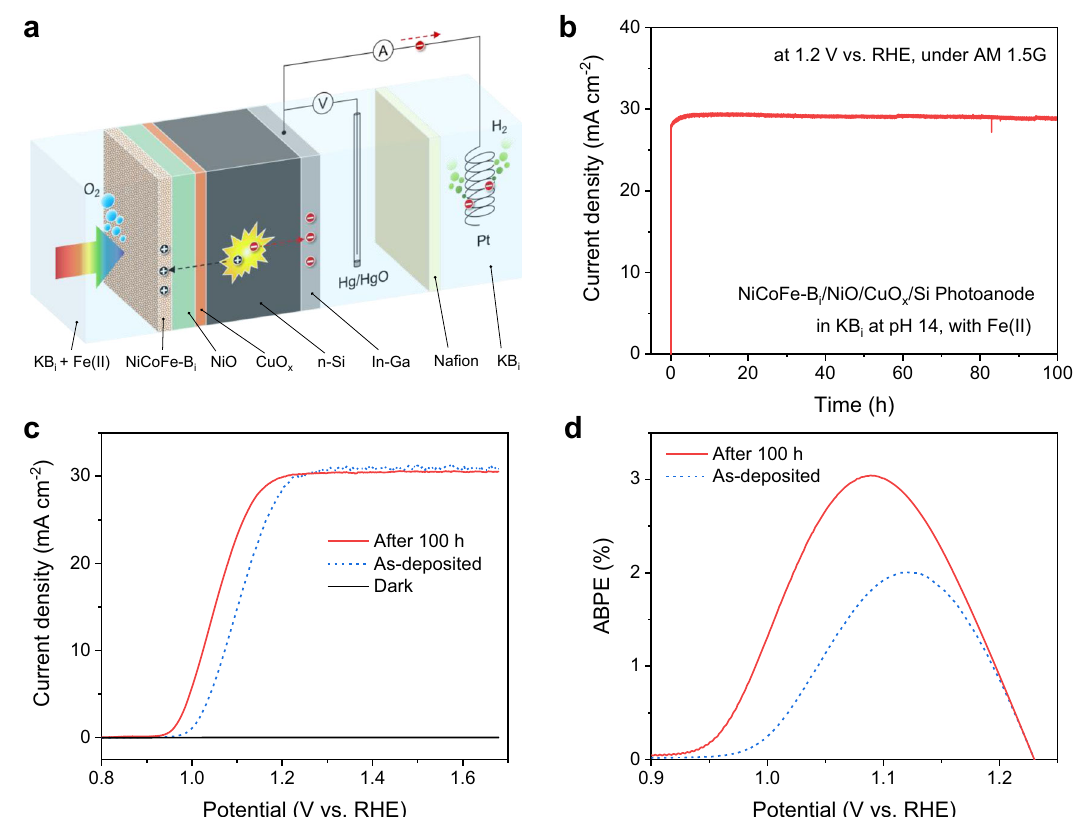
Fig. 5 PEC performance of an integrated NiCoFe-B i /NiO/CuO x /n-Si photoanode. a Schematic illustration of the PEC device. b Chronoamperometric curve of the photoanode measured at 1.2 V vs. RHE under AM 1.5 G for 100 h. c J – V curves of the photoanode before and after the stability test under AM 1.5G and in the dark. d ABPE curves of the photoanode before and after the stability